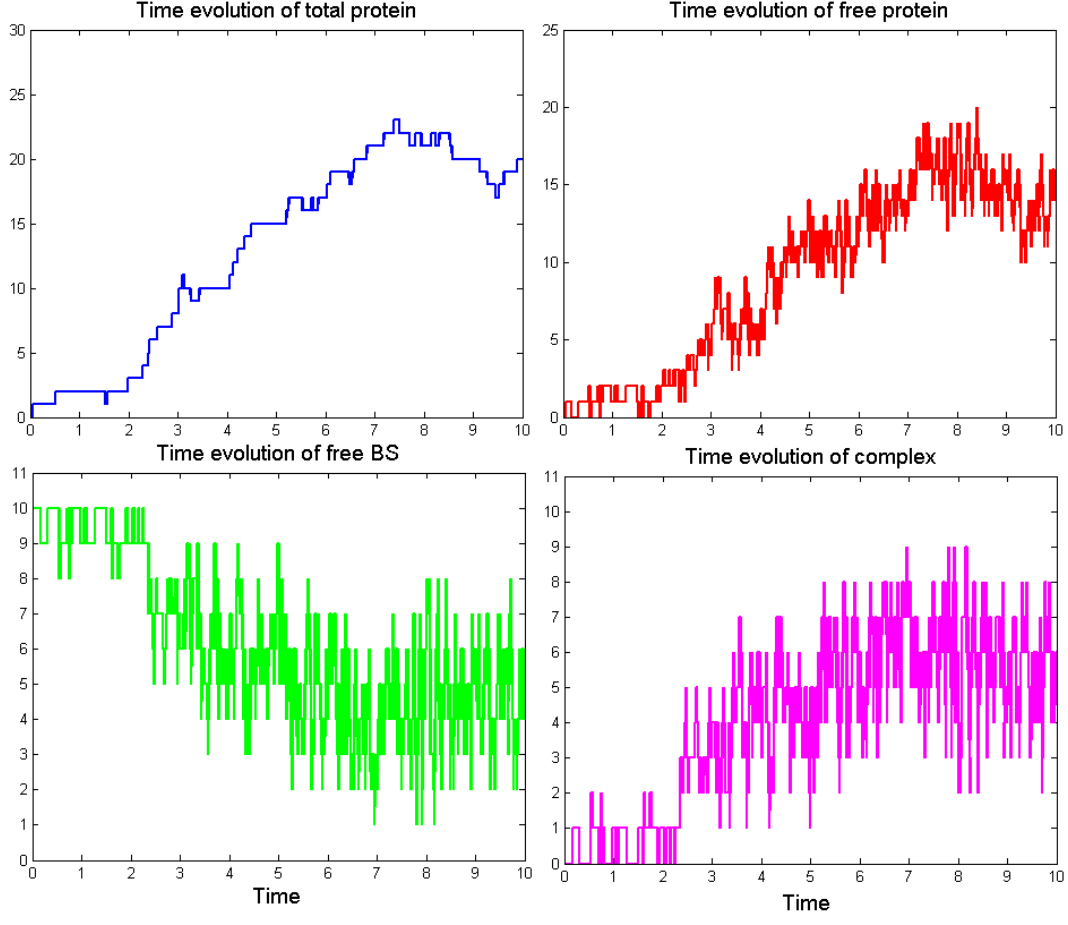
Fig. 1: Simulation using the Gillespie